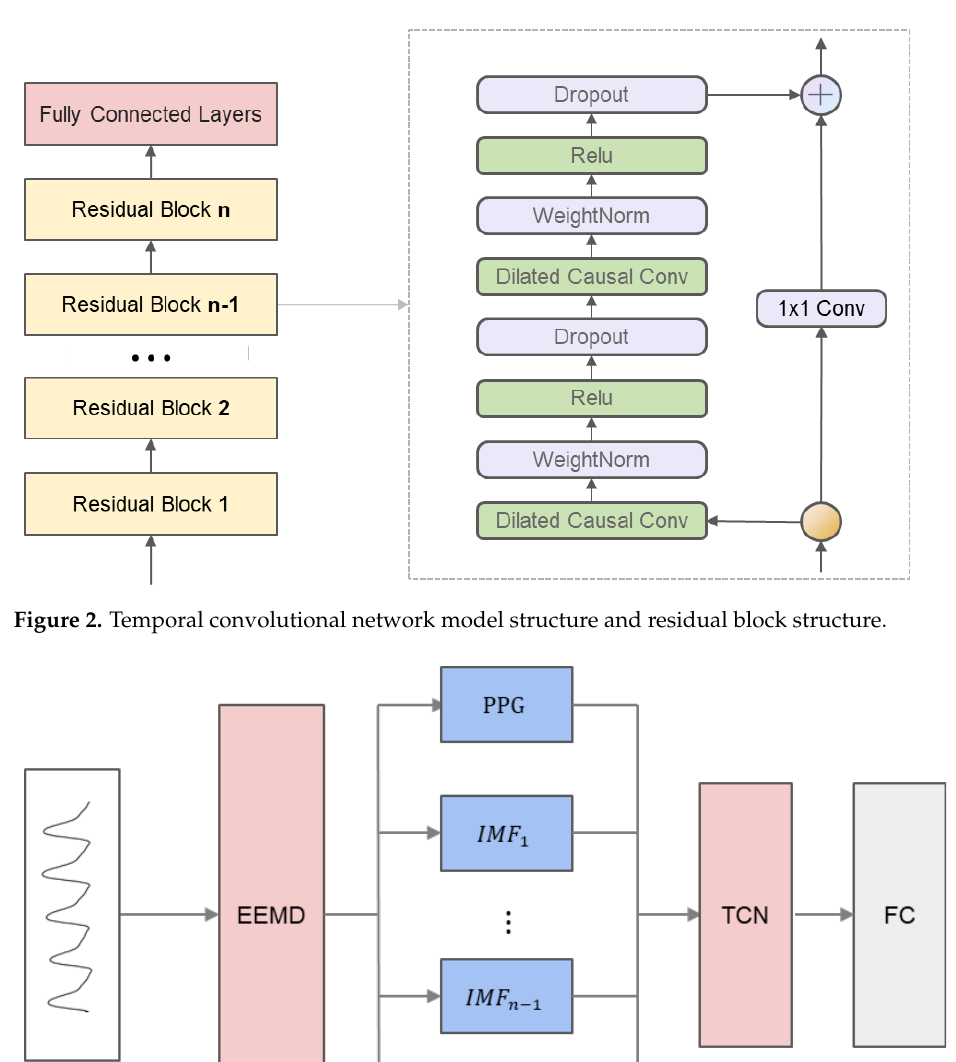
Figure 2. Temporal convolutional network model structure and residual block structure.